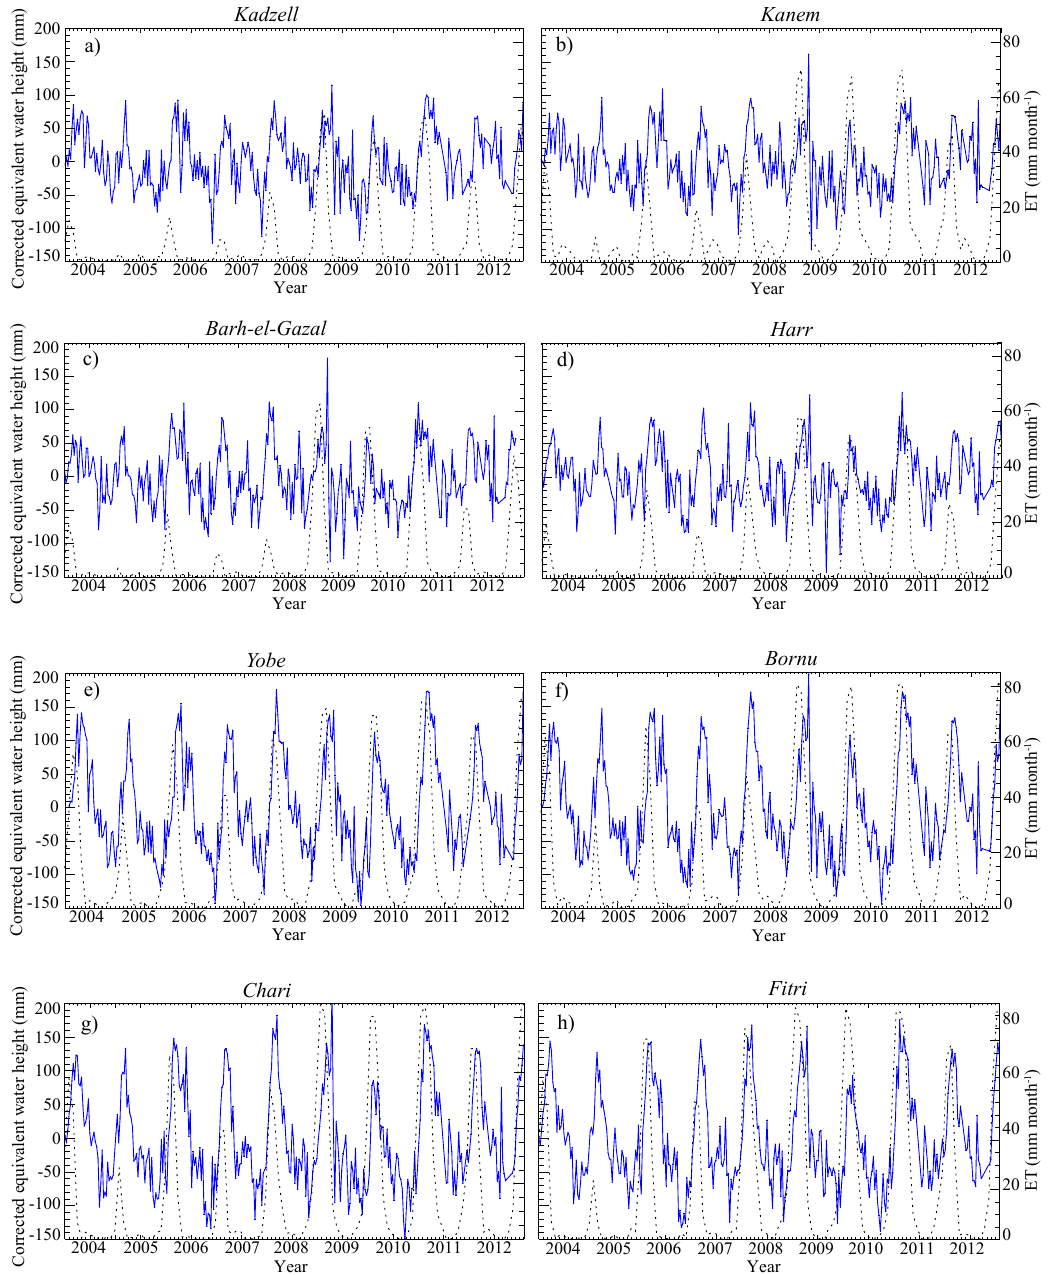
Figure 11. Each plots represent the GRACE water mass estimation (solid line), while the dashed line represents the ET